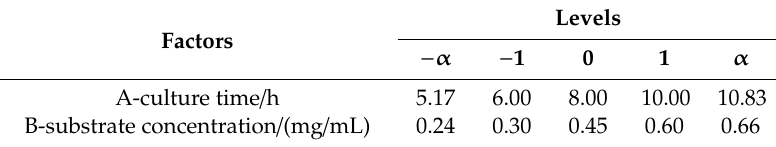
Table 9. Parameters and level setting in central composite